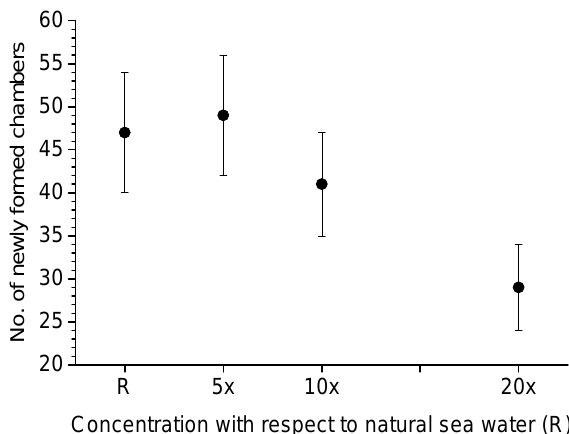
to reflect differences in elemental uptake between individ-